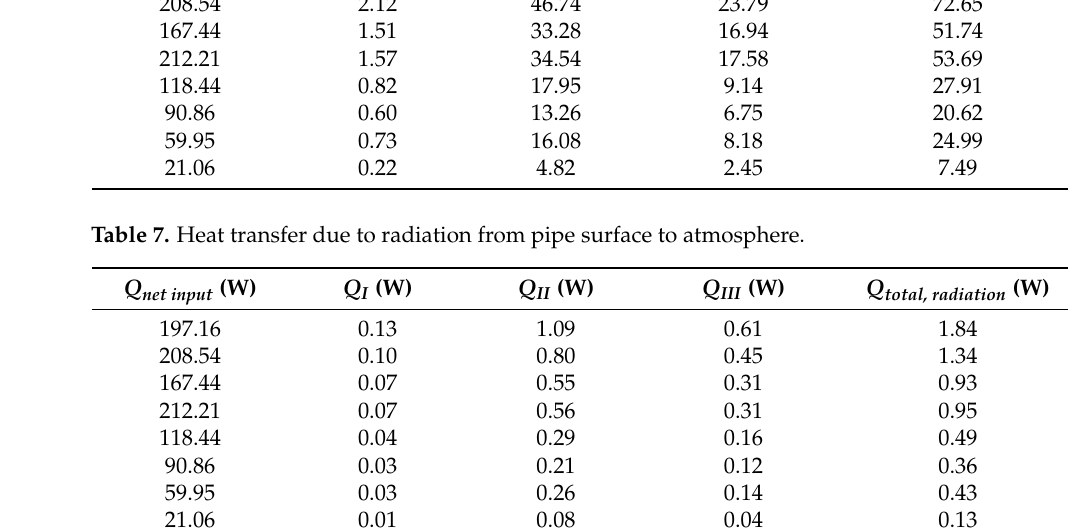
Table 6. Heat transfer due to convection from pipe surface to atmosphere.